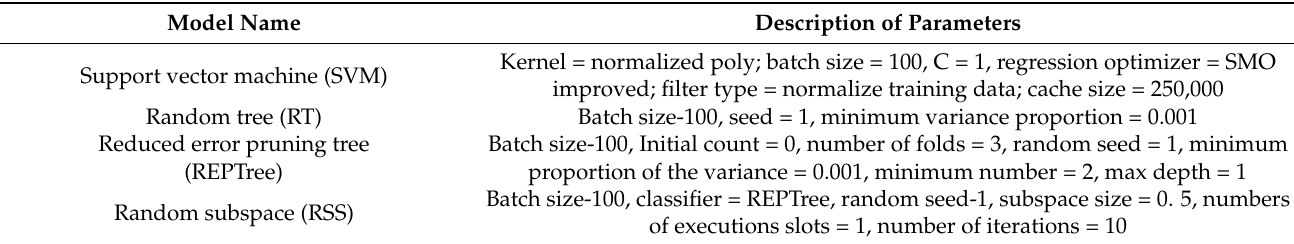
Figure 4. Graphic schematic layout of support vector machine. Table 2. The parameters of the machine learning algorithm used for evaporation